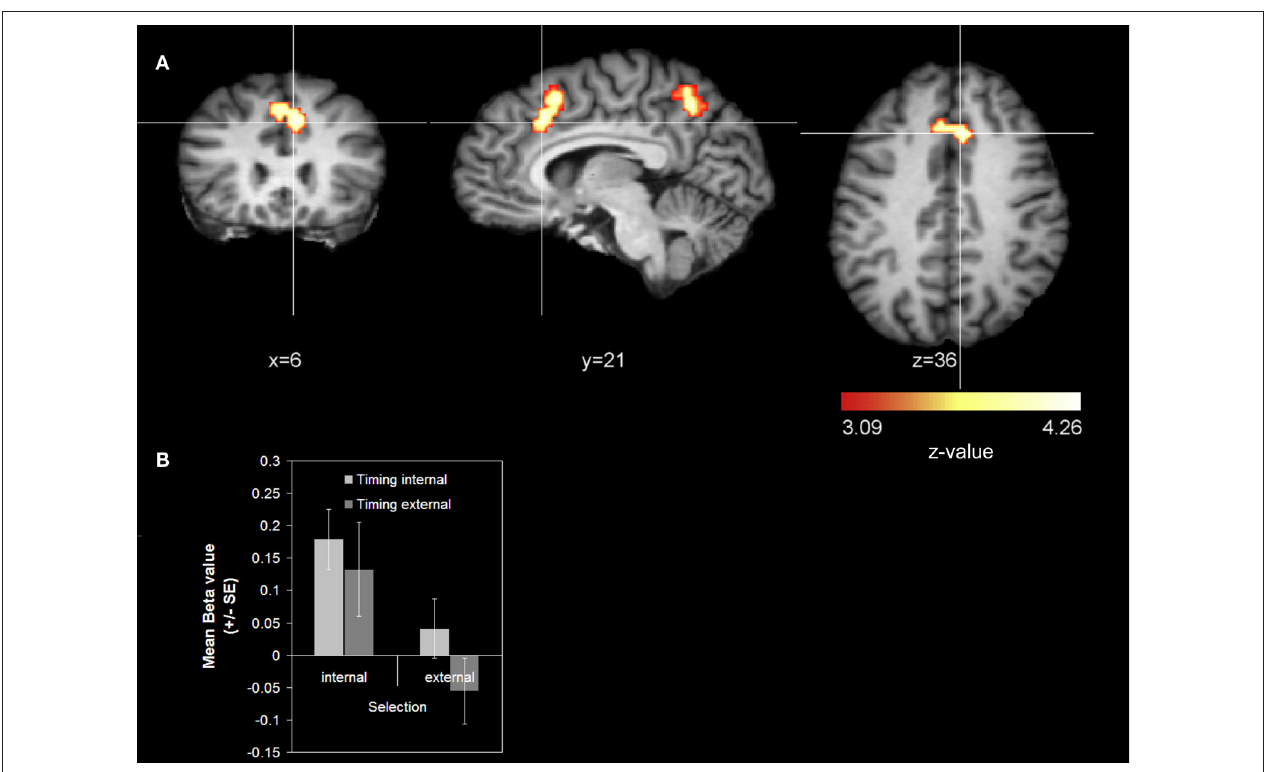
FIGURE 2 | Main effect action selection (cue-related activity). (A) Whole-brain analysis. The contrast was averaged over 14 subjects ( z -threshold at z = 3.09, corrected) and mapped to an individual brain from the in-house database. The comparison internal action selection > external action selection is shown. (B) Signal strength analysis. The diagram reports mean beta values for the RCZ coordinate ( x = 6, y = 21, z = 36).